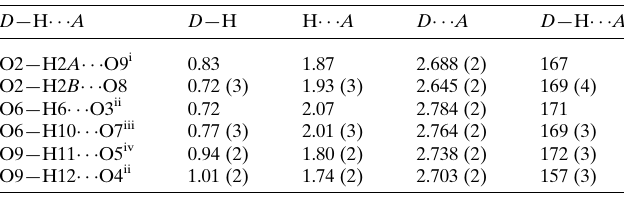
Table 1 Hydrogen-bond geometry (A˚ , (cid:3)